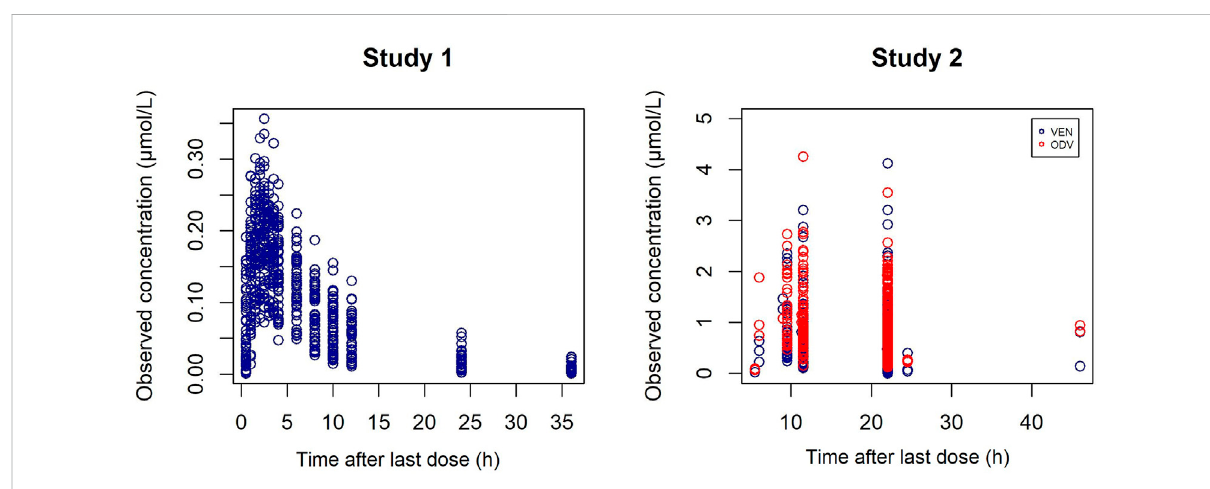
FIGURE 2 Individual C-t pro fi les of VEN (blue) and ODV (red) in study 1 (left) and study 2 (right).